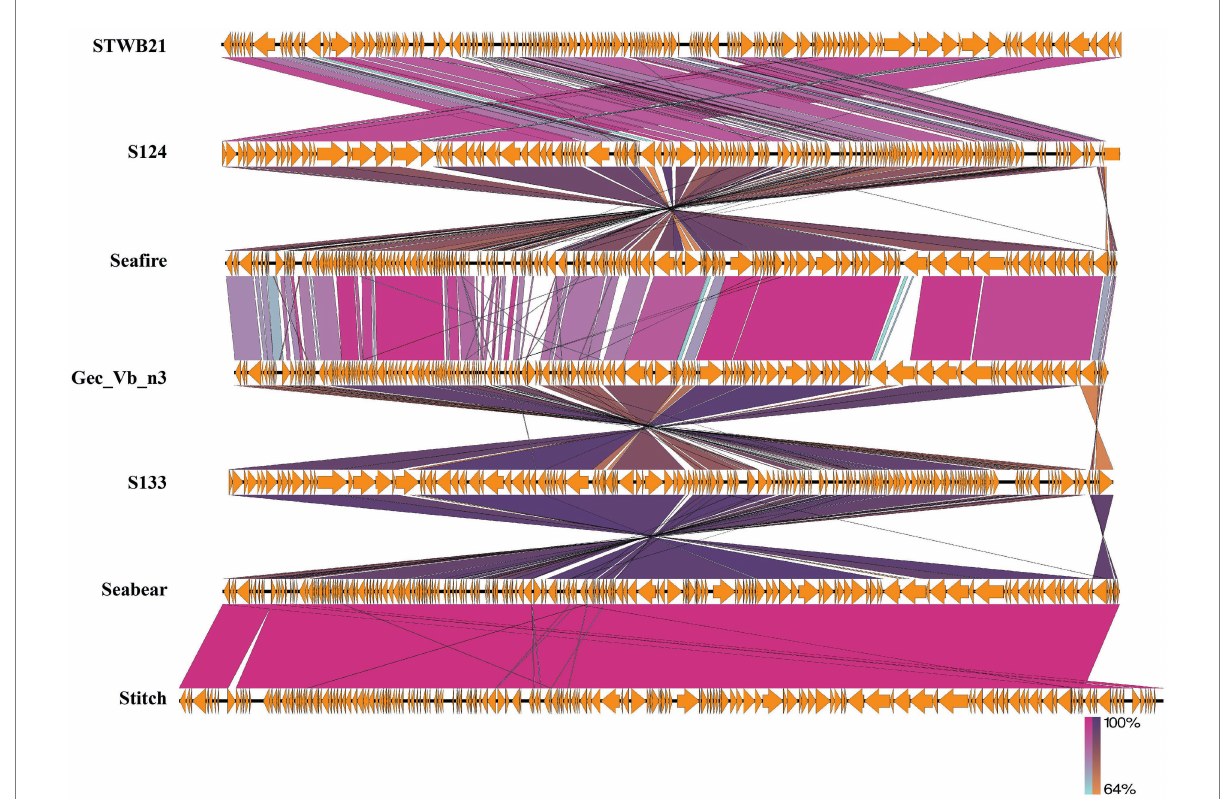
FIGURE 7 Genomic comparison of the phage STWB21 with other six homologous Salmonella phages using Easyfig application. Homologous ORFs or genes are present in yellow, and the percentages of amino acid identities are shown in different colors. Arrows indicate ORFs with either rightward or leftward